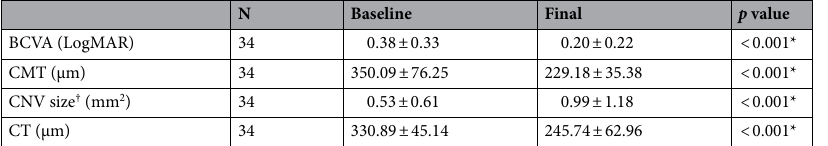
Table 2. Difference in best corrected visual acuity, central macular thickness, size of choroidal neovascularization, and choroidal thickness between baseline and 3-year follow-up. Wilcoxon Signed-Rank